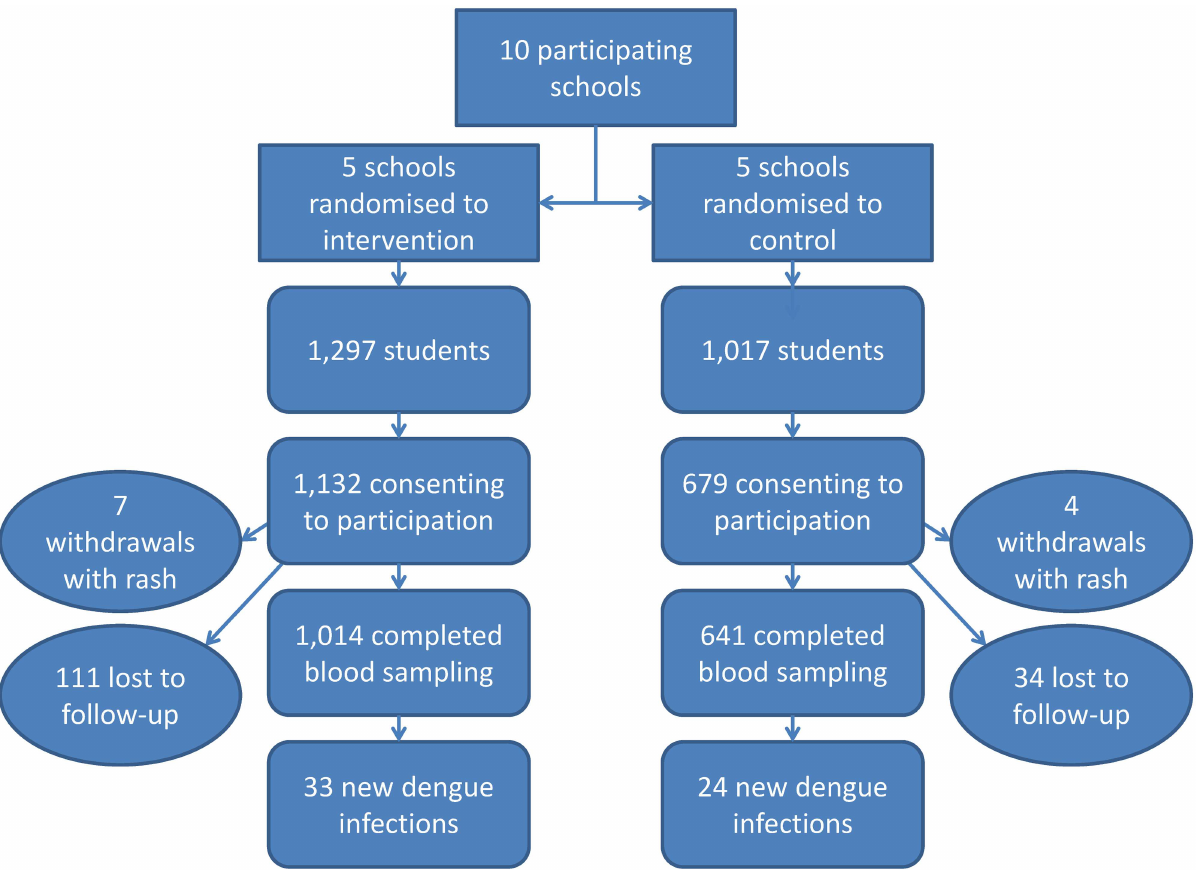
Fig 1. Flowchart showing numbers of participants in both intervention and control groups at all stages of the